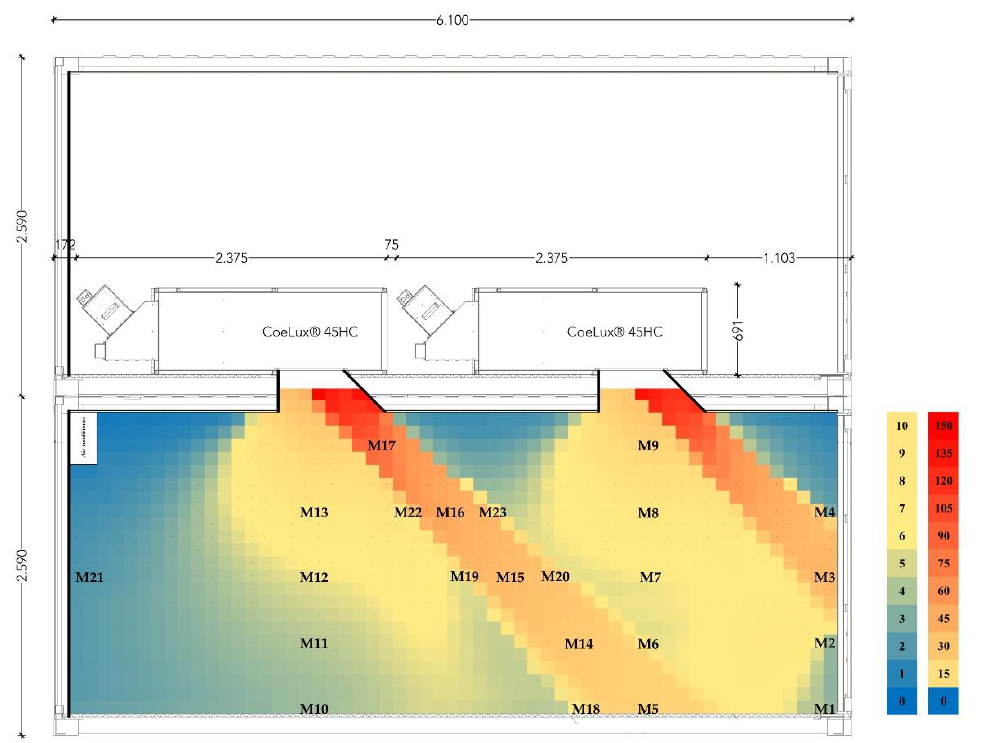
Figure 7. The photosynthetically active radiation (PAR) color-scale map of the double container showroom at Insubria University Campus (Varese, IT). The PAR values in the figure are given in μmol m −2 s −1 . Spectra measurements (M) were taken at positions M1 to M23.